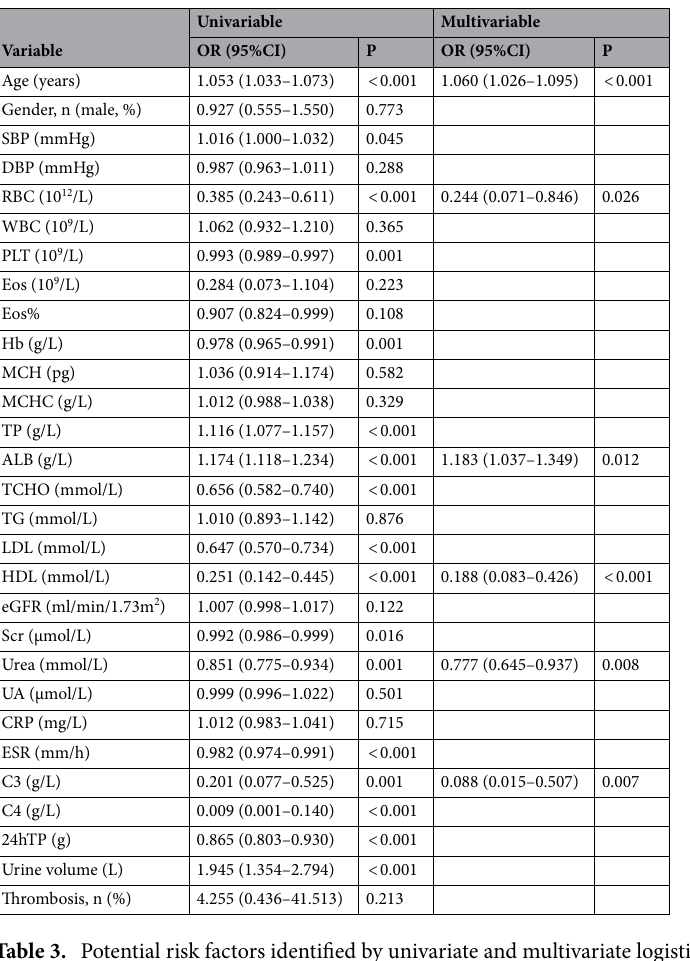
Table 3. Potential risk factors identified by univariate and multivariate logistic regression analysis.